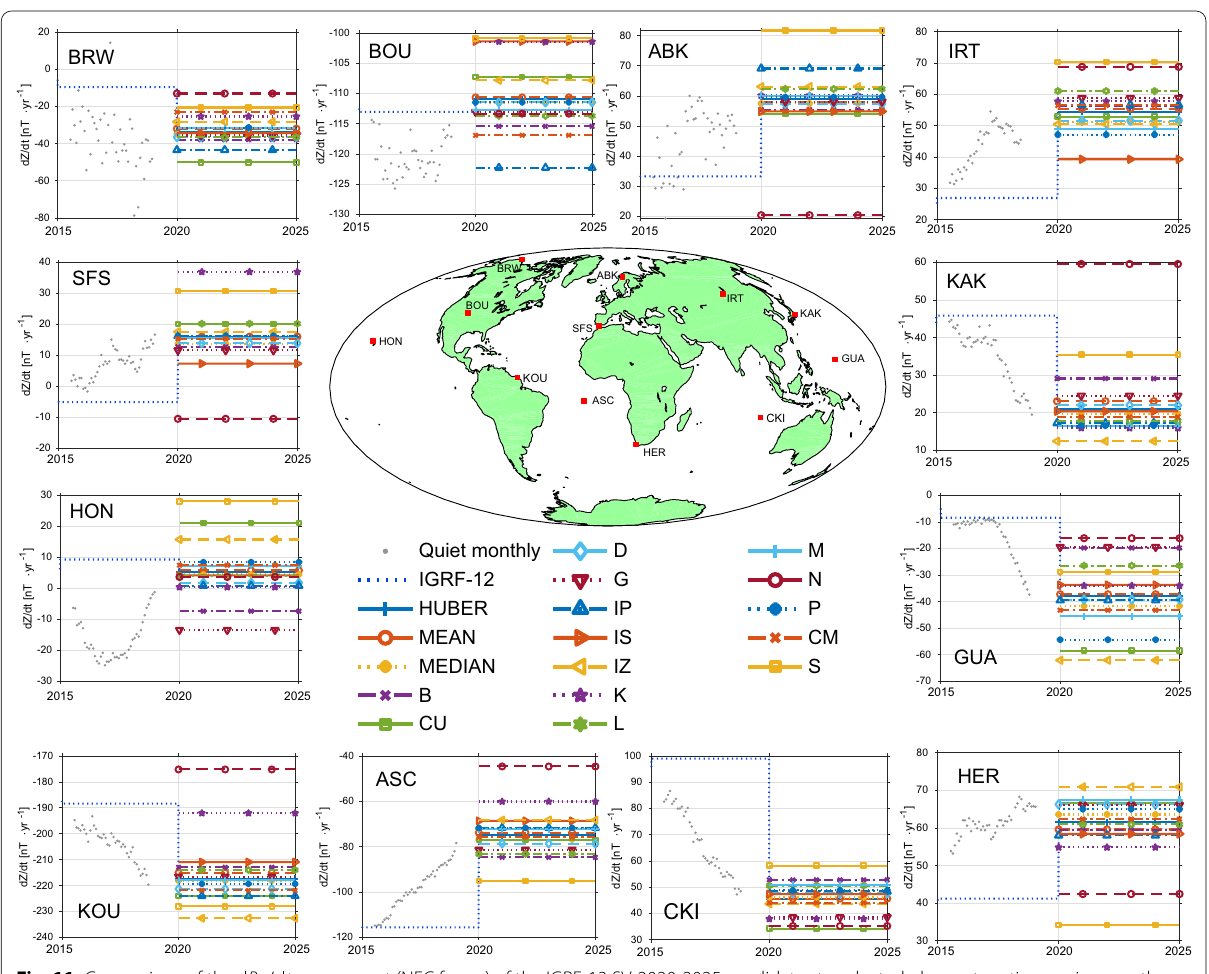
Fig. 11 Comparison of the d B z / d t component (NEC frame) of the IGRF-13 SV-2020-2025 candidates to selected observatory time-series over the